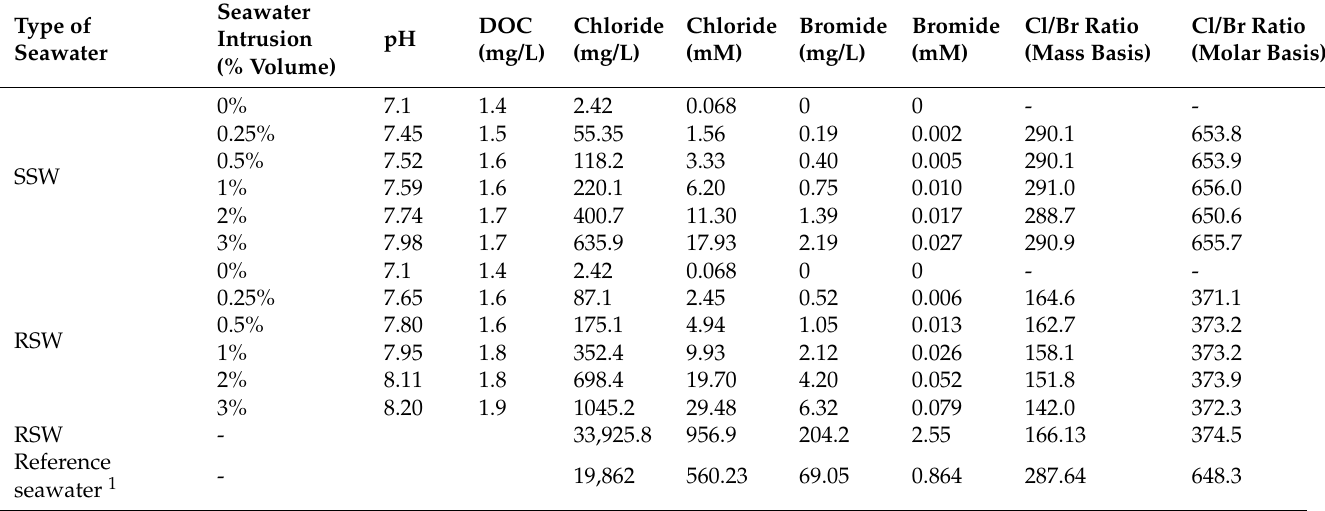
Table 2. Raw water characteristics of seawater and of water samples simulating seawater